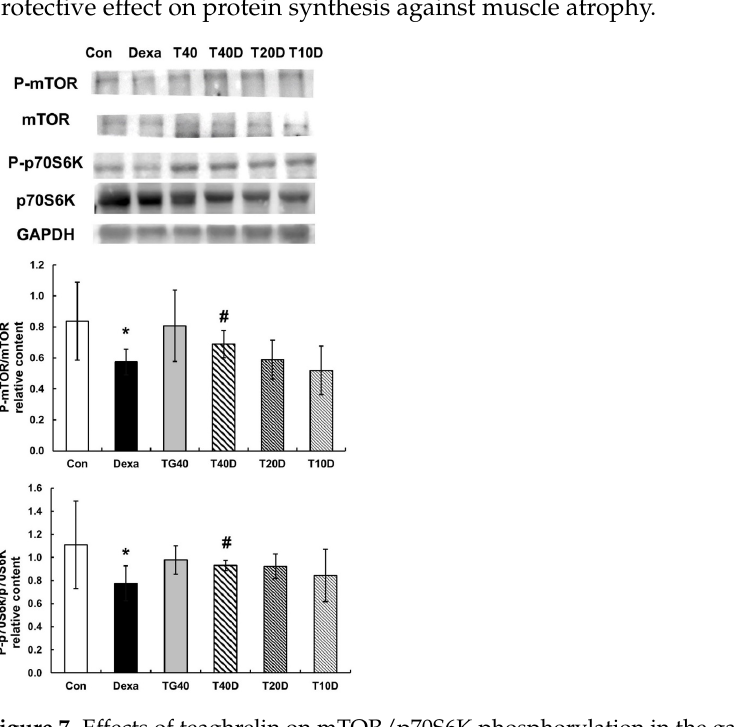
Figure 7. Effects of teaghrelin on mTOR/p70S6K phosphorylation in the gastrocnemius muscles of Dexa-treated rats. At the end of experiment, the phosphorylation levels of mTOR and p70S6K (P-mTOR and P-p70S6K) were measured in the gastrocnemius muscles of Dexa-treated rats by Western blotting with antibodies against P-mTOR, mTOR, P-p70S6K, p70S6K. GAPDH was used as a loading control. The Con, Dexa, TG40, T10D, T20D and T40D groups are defined in Figure 1. The results were analyzed using one-way ANOVA. Values are presented as the mean ± SD (n = 5 or 6). * p < 0.05 versus Con; # p < 0.05 versus Dexa.